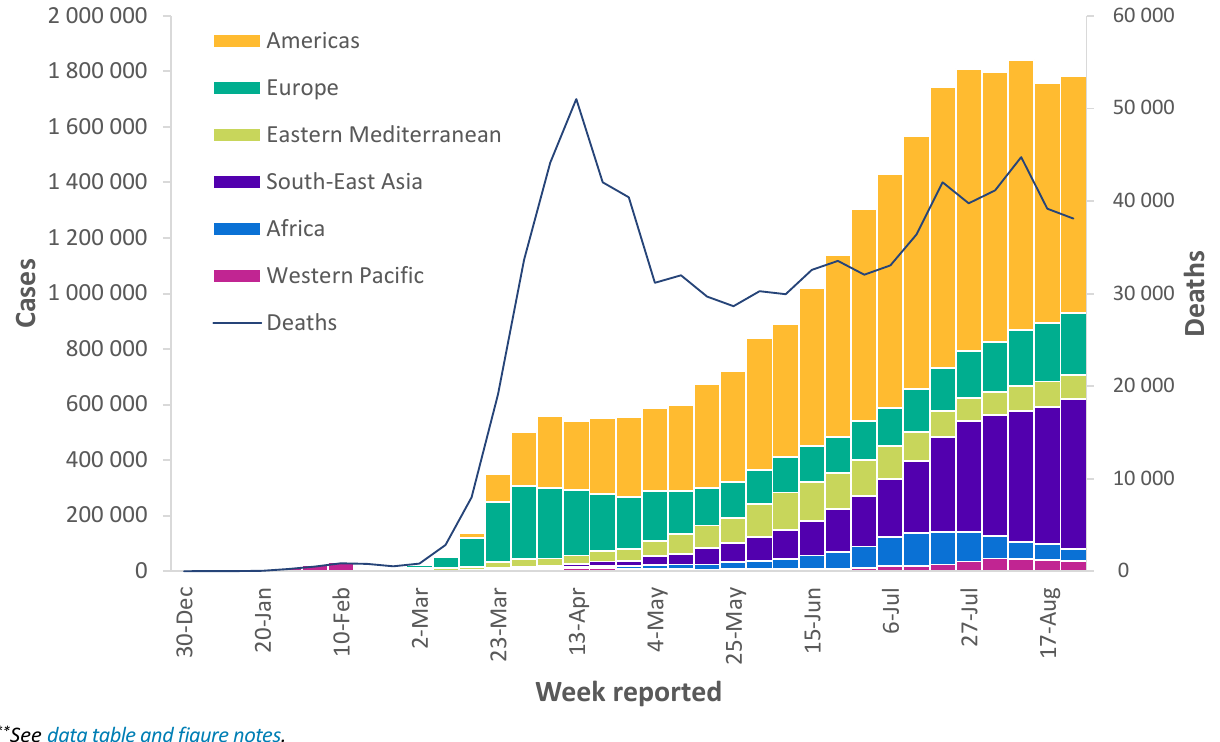
Figure 1: Number of COVID-19 cases and deaths reported weekly by WHO region, 30 December to 30